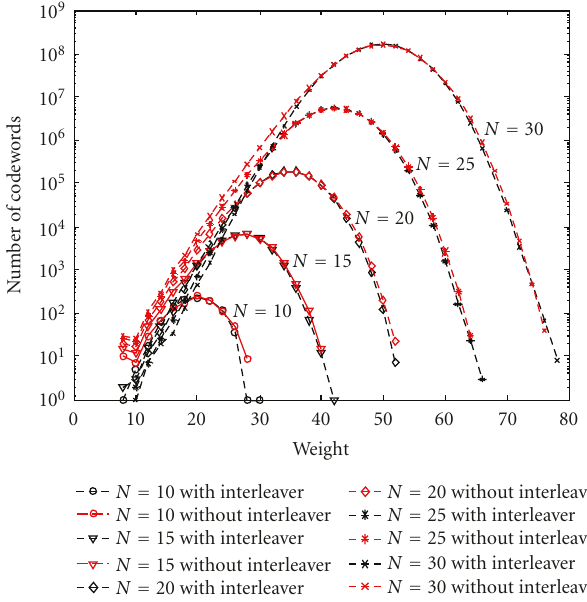
Figure 5: Simulation results for di ff erent generator polynomials. Figure 6: The e ff ect of interleaver on weight distribution in pro- posed asymmetric turbo